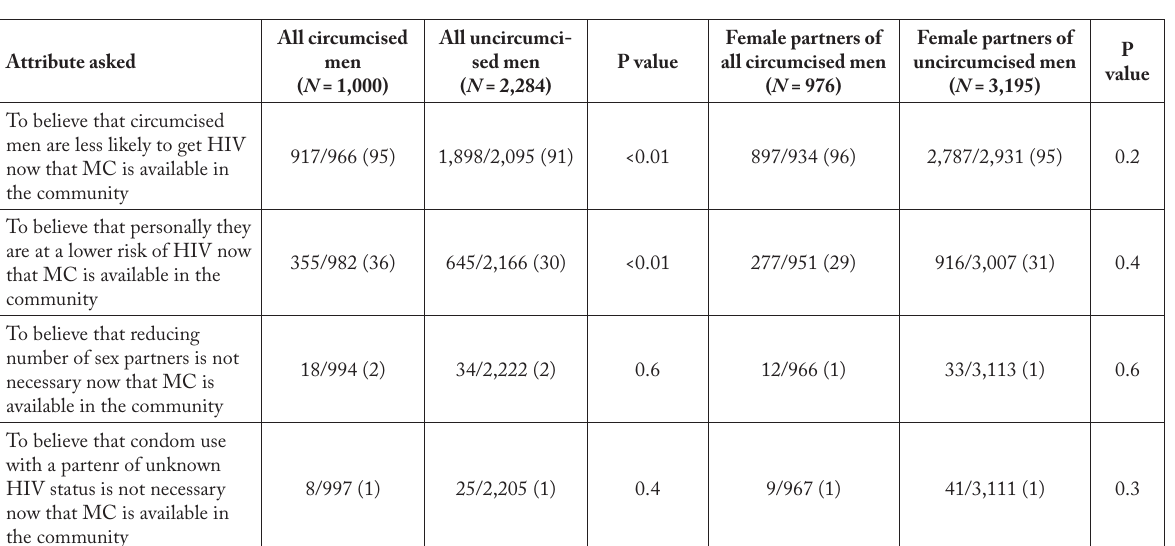
Table 5. Perceptions about HIV Risk among Circumcised and Uncircumcised Males (n = 3,284) and Female Partners of Circumcised and Uncircumcised Males ( n = 4,171).